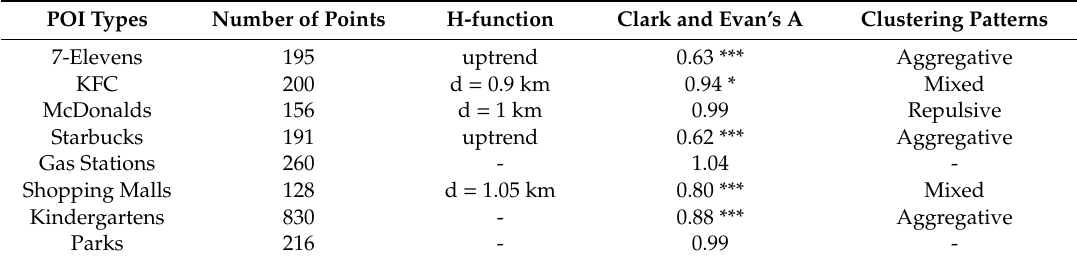
Table 2. Distribution pattern for di ff erent types of POIs.